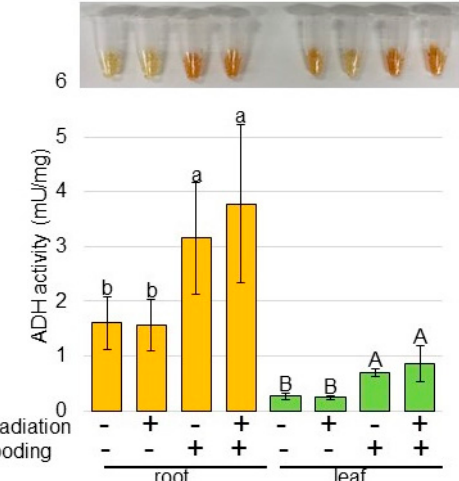
Figure 4. Activity assay of ADH involved in fermentation in wheat irradiated with millimeter waves under flooding stress. Wheat seeds were irradiated with (+) or without ( − ) 20 mW millimeter waves for 20 min and exposed with (+) or without ( − ) flooding stress. ADH activity was analyzed in protein extracted from root and leaf of wheat. The data are given as the mean ± SD from three independent biological replicates. Mean values in each point with different letters are significantly different according to one-way ANOVA followed by Tukey’s multiple comparisons ( p <